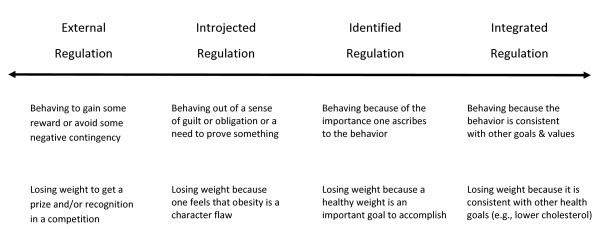
The Extrinsic Motivation Continuum.